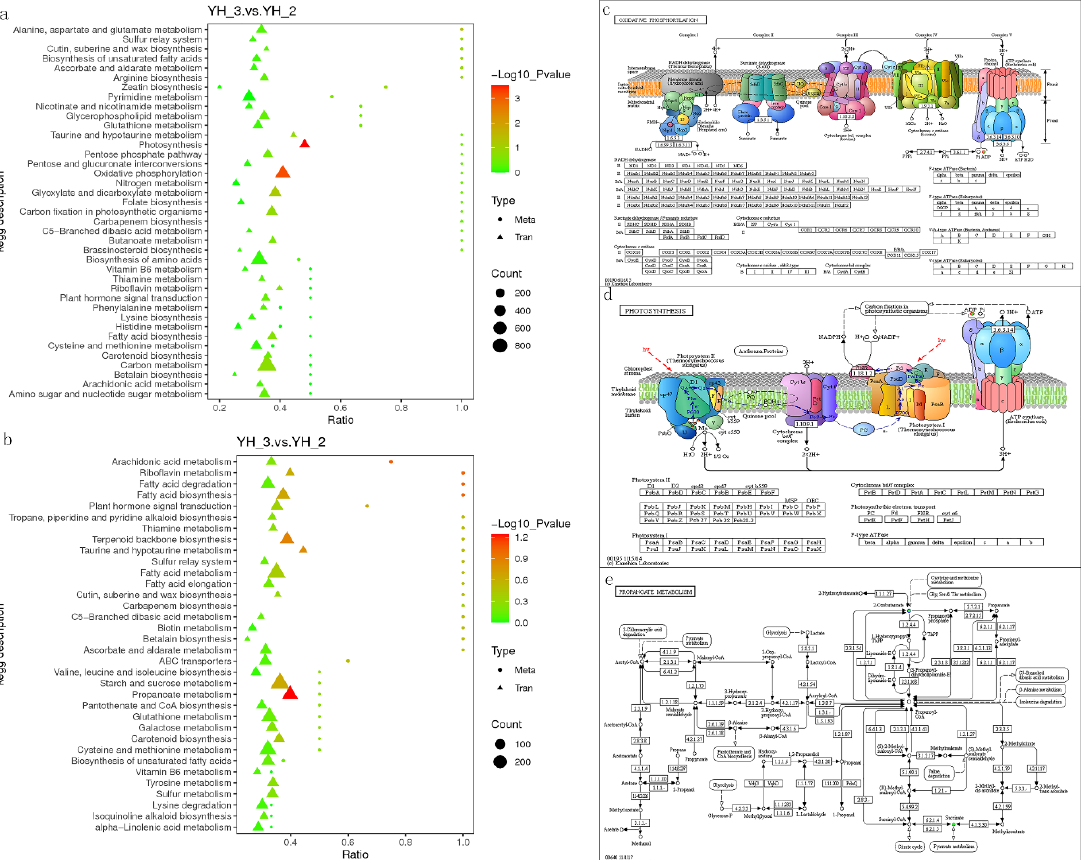
Figure 6. Joint analysis of the differentially expressed genes and differentially accumulated metabolites in YH_3 vs. YH_2. ( a ) Scatter plot of differential genes and metabolites in positive polarity mode. ( b ) Scatter plot of differential genes and metabolites in negative polarity mode. ( c ) Differentially expressed genes and differentially accumulated metabolites simultaneously mapped to the oxidative phosphorylation (ko00190). ( d ) Differentially expressed genes and differentially accumulated metabo- lites simultaneously mapped to the photosynthesis (ko00195). ( e ) Differentially expressed genes and differentially accumulated metabolites simultaneously mapped to the propanoate metabolism (ko00640). Solid green circles indicate the metabolites noted, red circles indicate a significant gene or metabolite upregulation, blue circles indicate a significant gene or metabolite downregulation, and solid circles in green represents a gene that is both upregulated and